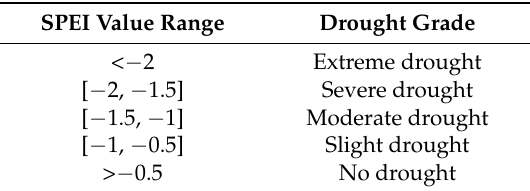
Intensity of drought based on Standardized Precipitation Evapotranspiration Index (SPEI) values. SPEI Value Range Drought